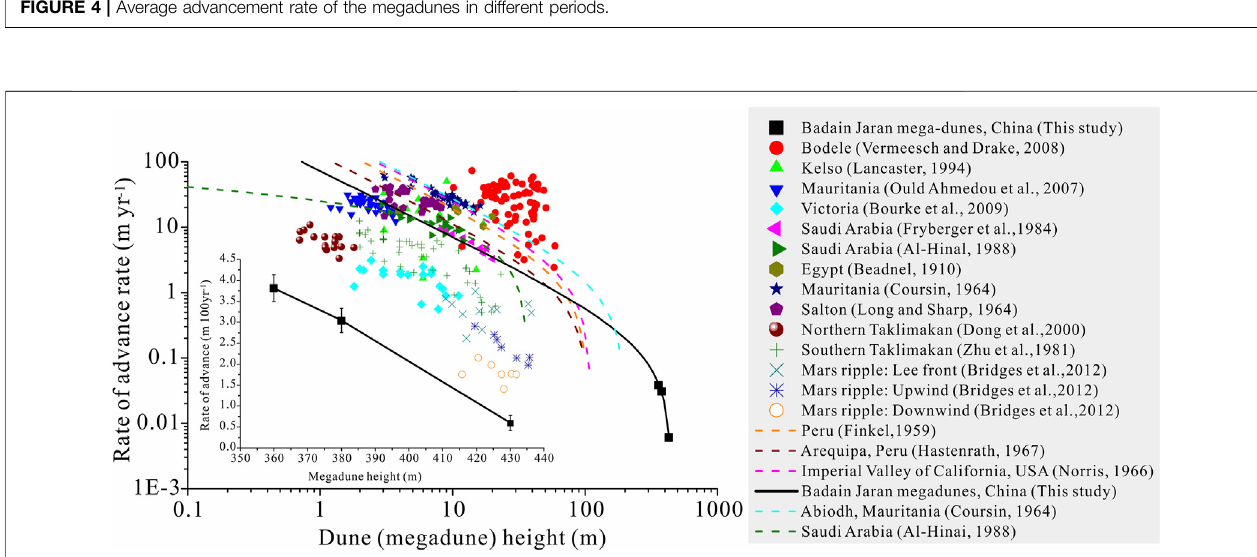
FIGURE 5 | Measured rates of transverse dune movement and the estimated advancement rate of megadunes in the Badain Jaran Sand Sea as a function of height. (Beadnell, 1910; Finkel, 1959; Coursin, 1964; Long and Sharp, 1964; Norris, 1966; Hastenrath, 1967; Zhu et al., 1981; Fryberger et al., 1984; AI-Hinai, 1988; Lancaster, 1994; Dong et al., 2000; Ould Ahmedou et al., 2007; Vermeesch and Drake, 2008; Bourke et al., 2009; Bridges et al., 2012)